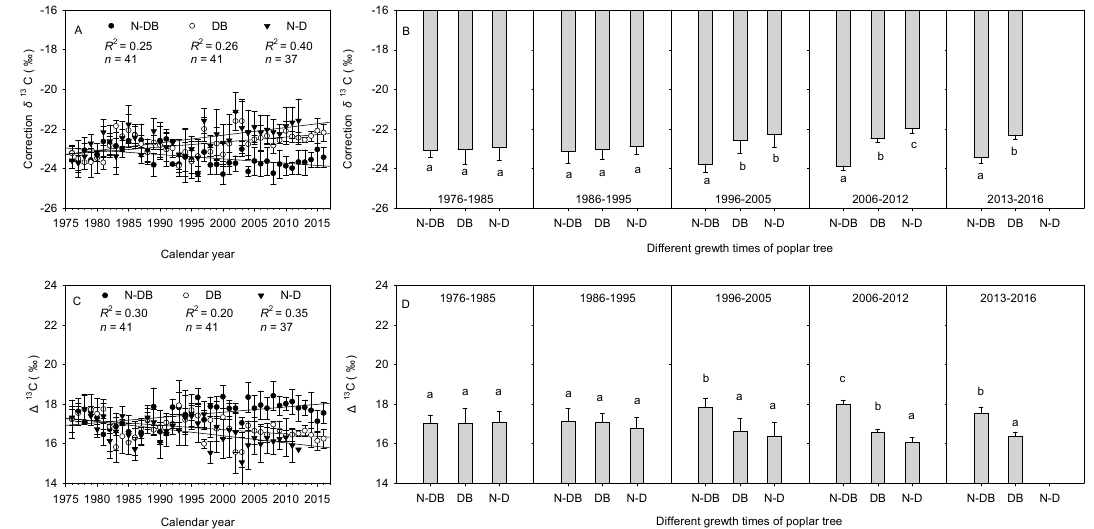
Figure 6. Difference in δ 13 C cor ( A , B ) and carbon isotope discrimination ∆ 13 C ( C , D ) among now-dead (N-D), dieback (DB), and non-dieback (N-DB) poplar trees at different growth times. Lower case letters indicate significant differences ( p < 0.05).